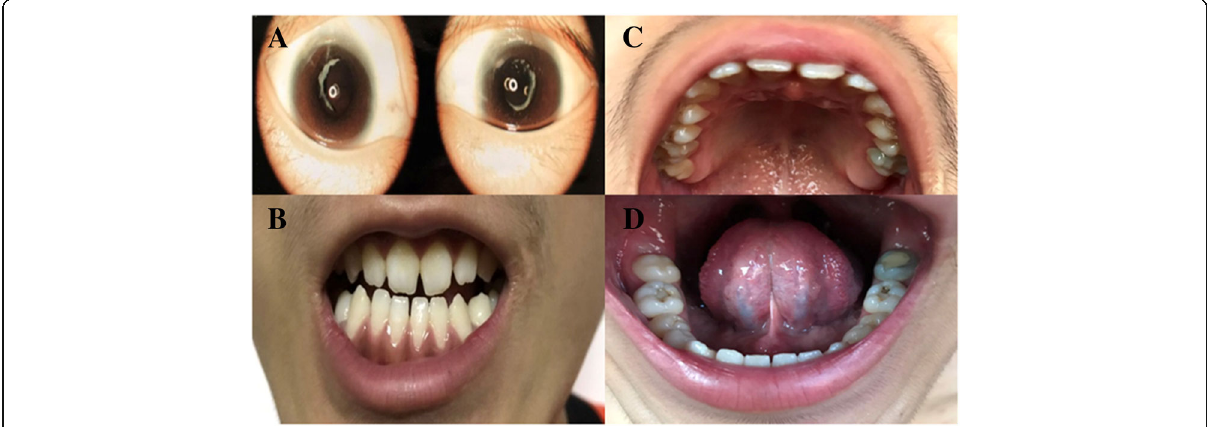
Fig. 1 Main clinical manifestations of the proband. a Slit lamp photograph showing that the proband presented with bilateral congenital cataracts; b The screwdriver blade-shaped incisors; c One missing maxillary second molar; d The mild mulberry-like